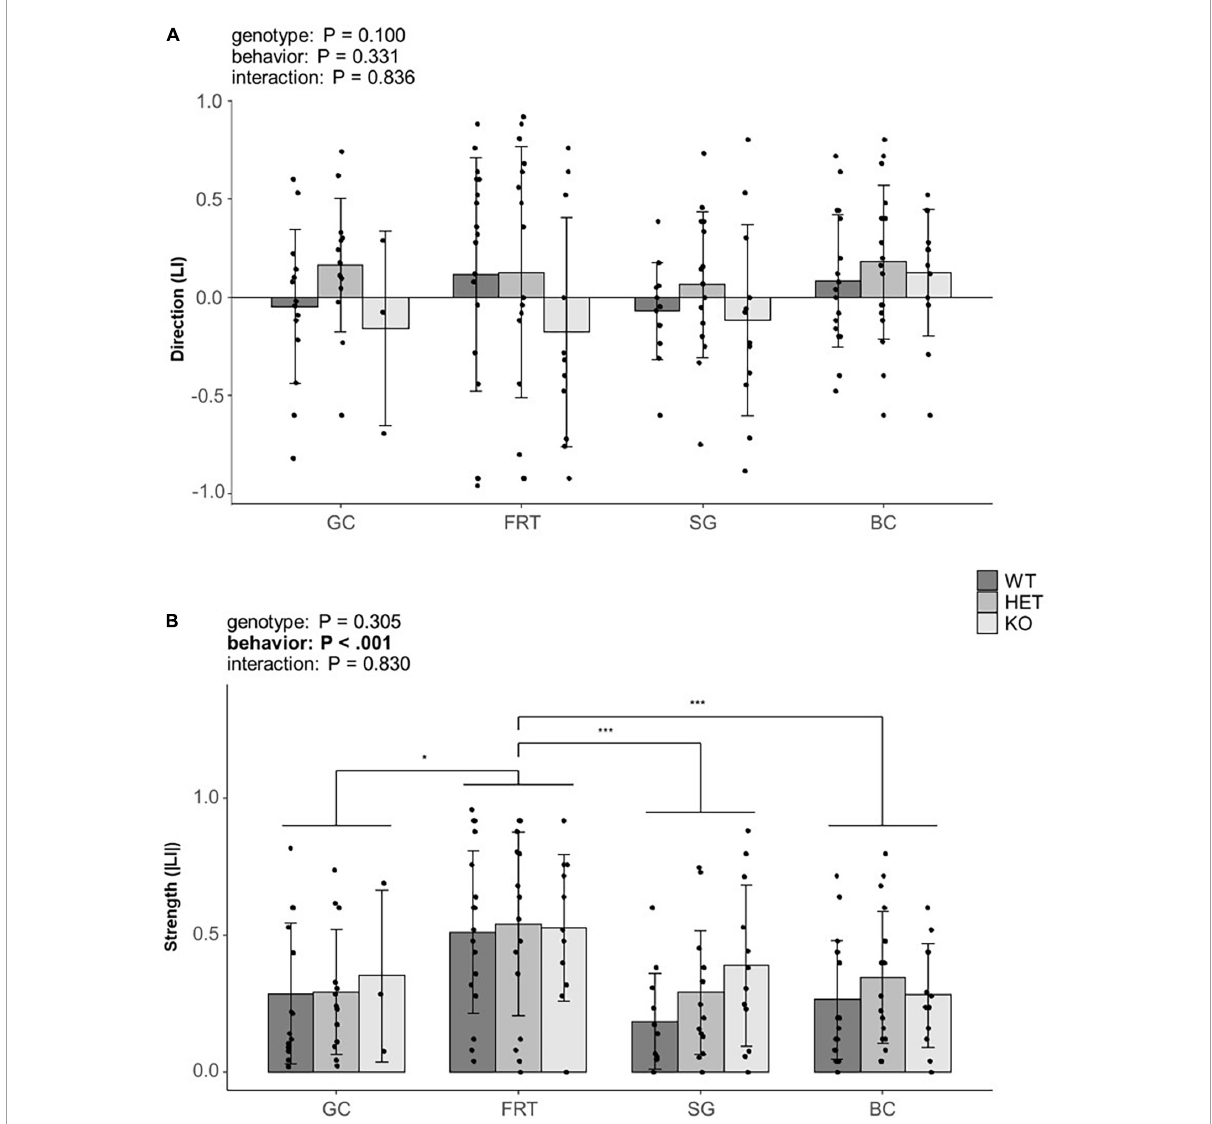
FIGURE4 Influence of genotype on behavioral lateralization. (A) The direction (LI) and (B) the strength (|LI|) of lateralization of mice from three different genotypes (5-HTT +/+, 5-HTT +/– and 5-HTT − / − ) for four different behaviors [grid climbing (GC), food-reaching (FRT), self-grooming (SG), and barrier crossing (BC)] was observed in two sessions (5 weeks apart). Statistics: Linear mixed model, post hoc Tukey HSD; Sample sizes: GC + / + = 14, GC + / - = 13, GC - / - = 3, FRT + / + = 18, FRT + / - = 16, FRT - / - = 11, SG + / + = 12, SG + / - = 15, SG - / - = 12, BC + / + = 18, BC + / - = 18, BC - / - = 12. Data is presented as means ± SD. * P ≤ 0.05; *** P ≤ 0.001. P -values of main effects are given as text. Significant post hoc effects are shown graphically. Behavior as main effect significantly affected the strength of